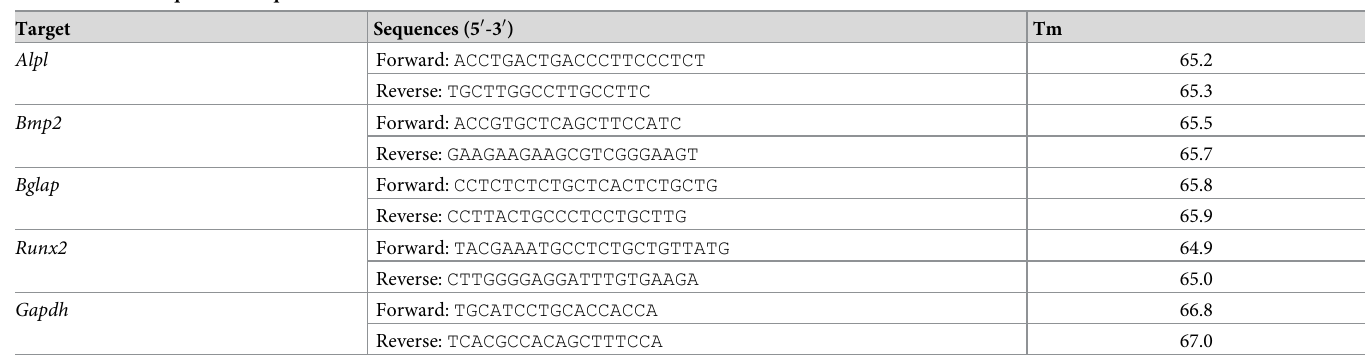
15 min at 4˚C. The supernatant were collected as the protein samples, and then their concen- trations were determined using Protein Assay Bicinchoninate kit (Nacalai Tesque). Protein samples (6 or 11 μ g) were incubated at 90˚C for 3 min with Sample Buffer Solution (6 × ) (Nacalai Tesque), and then separated by 12.5% sodium dodecyl sulfate-polyacrylamide gel electrophoresis (SDS-PAGE) and transferred onto PVDF membranes (Atto, Tokyo, Japan). Membranes were blocked in 0.1% bovine serum albumin (BSA) at room temperature for 1 h, and then incubated with the first antibodies diluted in PBS-Tween (0.137 M NaCl, 2.7 mM